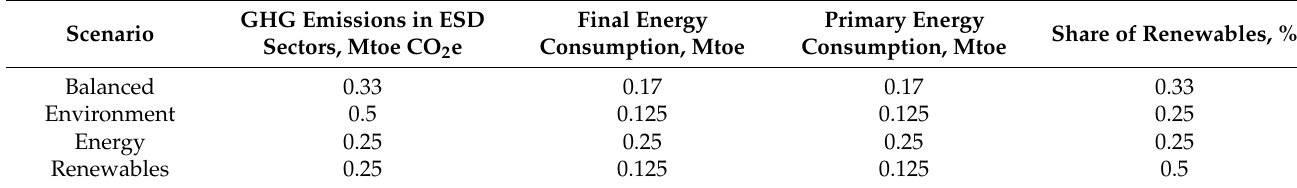
Table 4. Weights defining different assessment scenarios for low-carbon